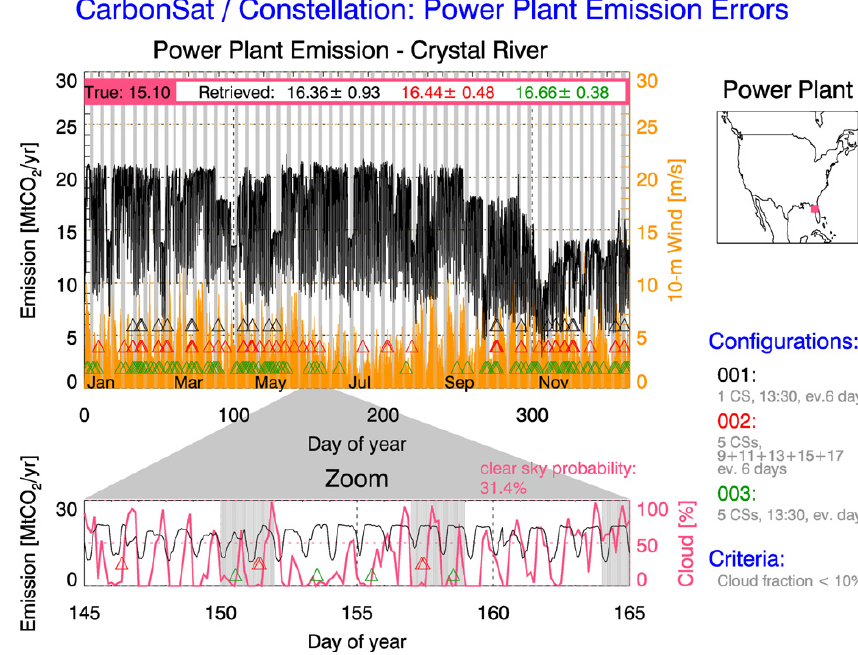
Fig. 9. Same as Fig. 6 for the power plant Crystal River in